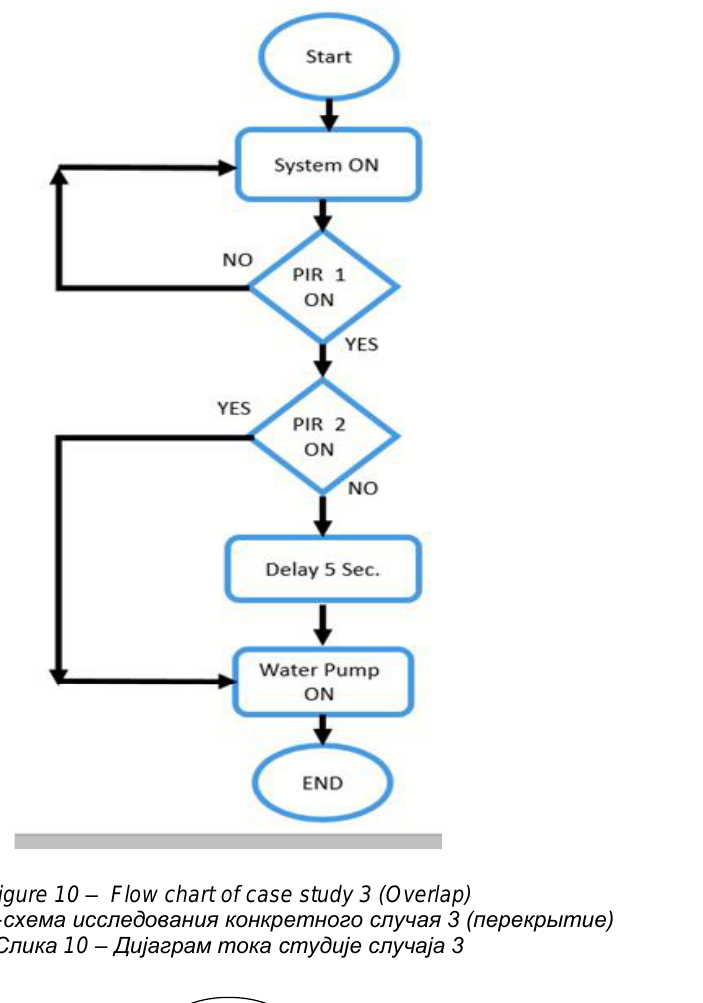
Figure 10 – Flow chart of case study 3 (Overlap) Рис. 10 – Блок-схема исследования конкретного случая 3 (перекрытие) Слика 10 – Дијаграм тока студије случаја